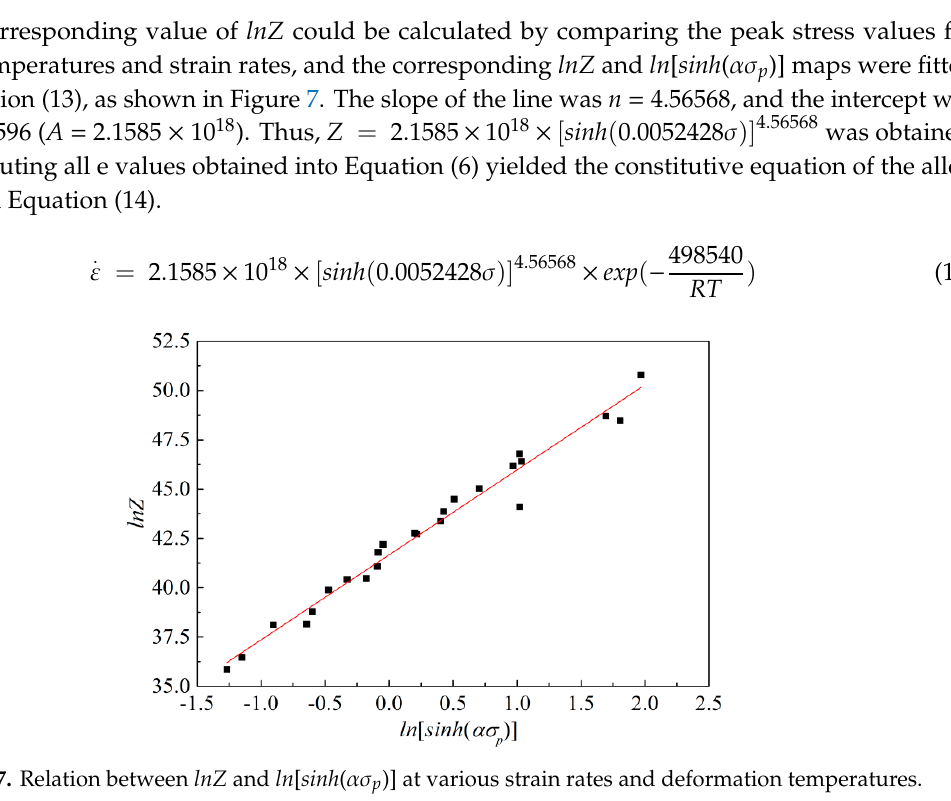
Figure 7. Relation between lnZ and ln [ sinh ( ασ p )] at various strain rates and deformation temperatures.